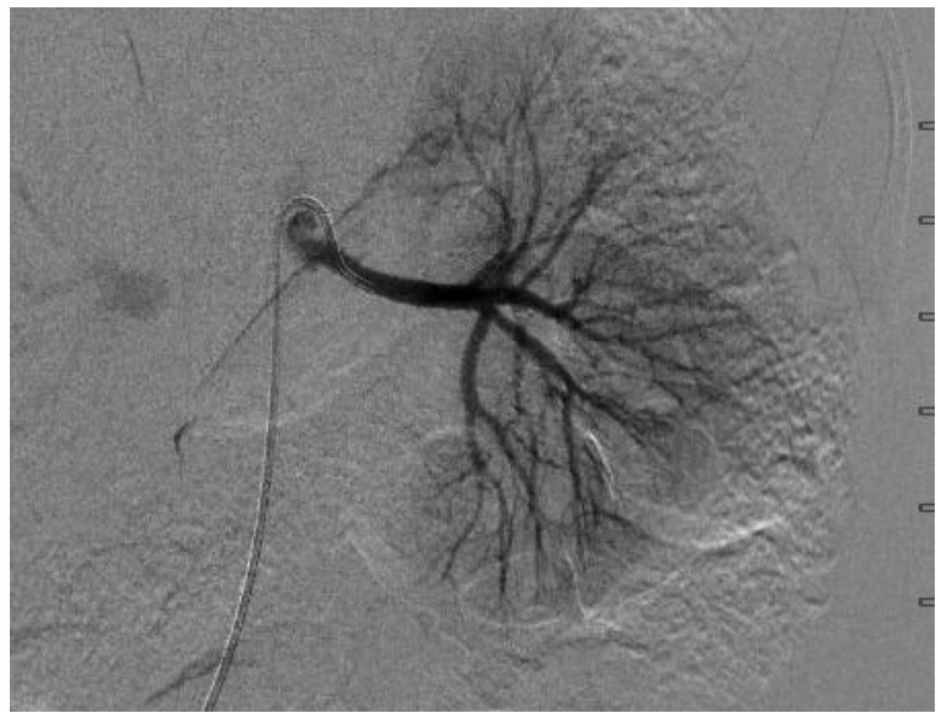
Figure 4. Digital subtraction angiography of the left renal artery, which showed no